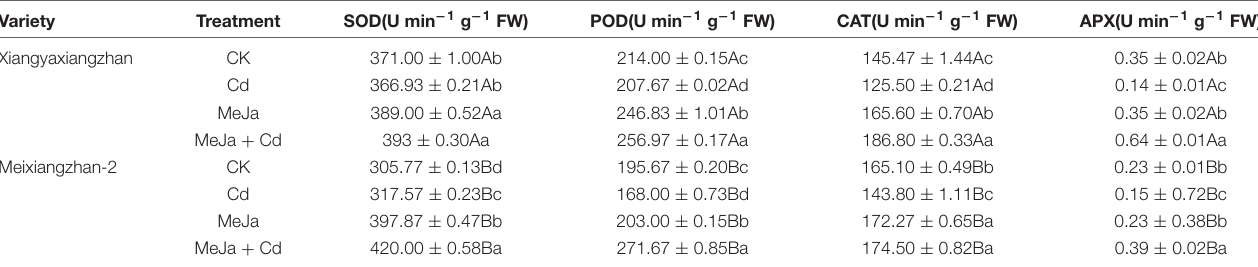
Three replicated means ( ± SE) were calculated for each treatment. Values with different letters indicate significant difference between cultivars and treatments at p < 0.05 least significant difference (LSD). CK; control (normal conditions); Cd:100 mg Cd kg − 1 of soil, MeJa: exogenous application of MeJa at 20 mM, and Cd + MeJa: 100 mg Cd kg − 1 of soil + exogenous MeJa application at 20